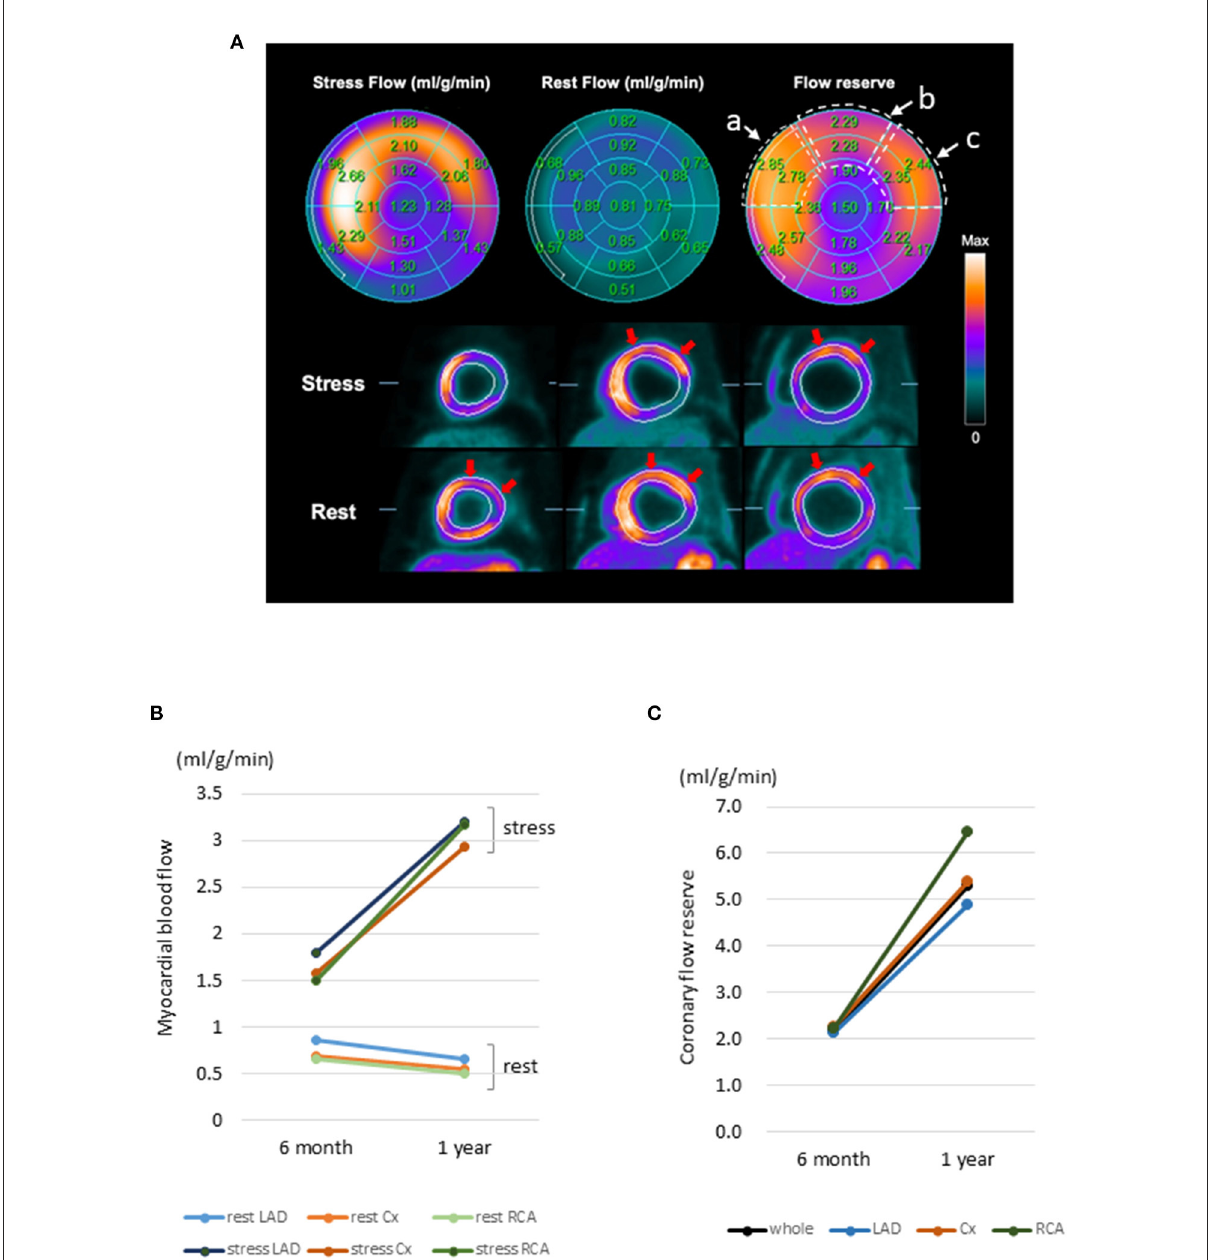
FIGURE4 13 N-ammonia PET images of myocardial blood flow at rest and during stress after hiPSC-CM sheet implantation. (A) Color-coded polar maps with superimposed 17-segment bull’s-eye grids with blood flow quantitated under stress and at rest, as well as flow reserve values, are shown in each segment (upper figures). Myocardial blood flow images (short axis) are shown in the lower figures. Red arrows indicate preserved myocardial flow reserves in the anteroseptal to lateral segments. The areas surrounded by the dotted line in the flow reserve figure show a: anteroseptal, b: anterior, and c: anterolateral regions, and the average values of the two area parts were calculated. (B) Change in myocardial blood flow. Myocardial blood flow in the segmental regions LAD, Cx, and RCA at rest and under stress. (C) Change in myocardial flow reserve. Myocardial flow reserve in the whole and each segmental region at 6 months and 1 year after hiPSC-CM patch transplantation. 13 N-ammonia PET, 13 N-ammonia positron emission tomography; hiPSC-CM, human induced pluripotent stem cell-derived cardiomyocyte; LAD, left anterior descending coronary artery; Cx, circumflex coronary artery; RCA, Right coronary